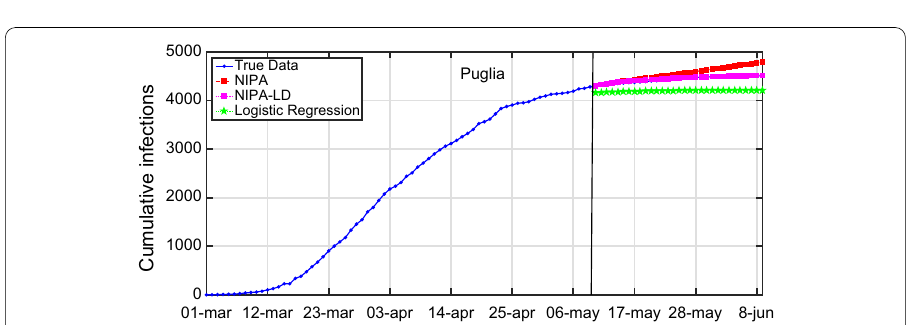
Fig. 8 Cumulative infections for